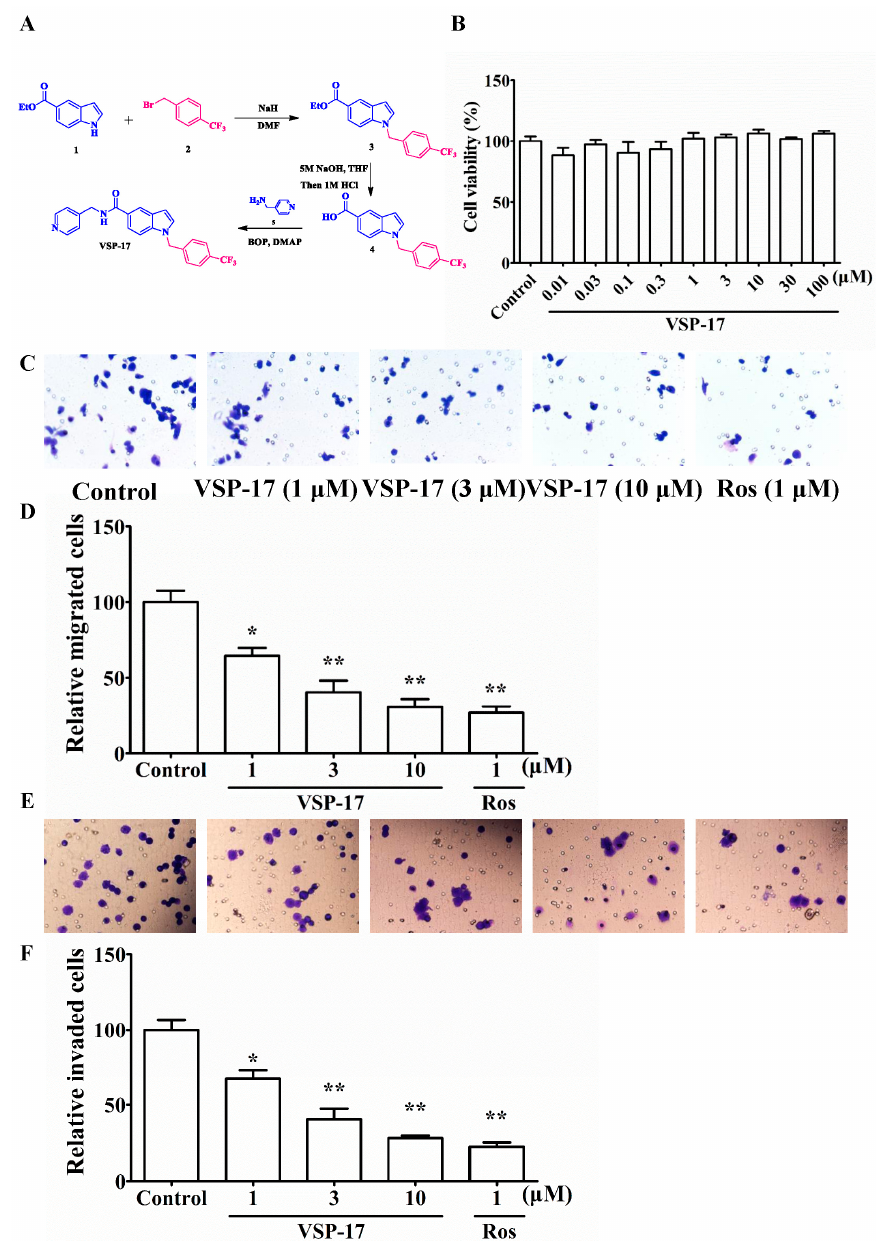
Figure 1. Synthesis of VSP-17 and effect of VSP-17 on MDA-MB-231 cell migration and cell invasion. ( A ) Synthesis of VSP-17; ( B ) Effect of VSP-17 on MDA-MB-231 cell viability; ( C , D ) Effect of VSP-17 on MDA-MB-231 cell migration. Cell migration was detected by using cell migration assay; ( E , F ) Effect of VSP-17 on MDA-MB-231 cell invasion. MDA-MB-231 cells were cultured in chambers with matrigel followed by treatment with VSP-17 (1, 3, 10 µ M) for 24 h. The number of cells invaded through the matrigel of chambers bottom were counted in three different regions. The data were expressed as the means ± S.E.M. of three independent experiments. * p < 0.05, ** p < 0.01 vs. control.